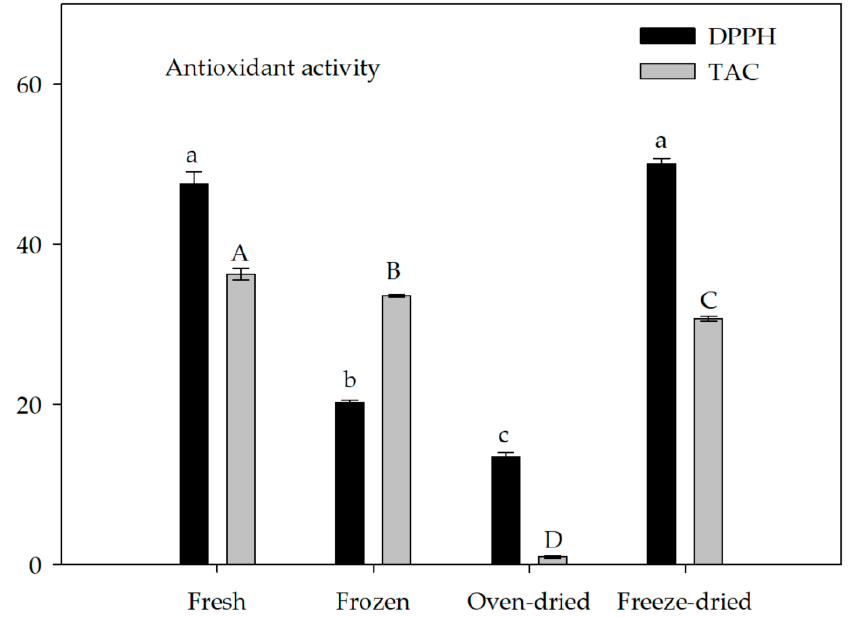
Figure 3. The 1,1-Diphenyl-2-Picrylhydrazyl radical scavenging activity (DPPH, % inhibition) and Total Antioxidant Activity (TAC, µ g α -tocopherol g D.W. − 1 ). Di ff erent letters indicate, within the same assay, significant di ff erences ( p ≤ 0.05) among A. platensis